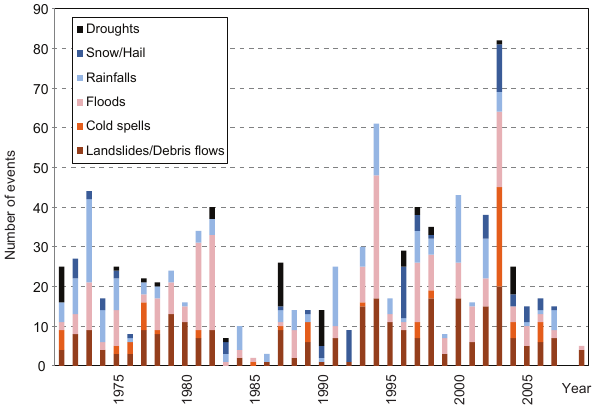
Figure 3. Number of climatic disasters in the region of Cusco and distribution according to type of event (1971–2009).